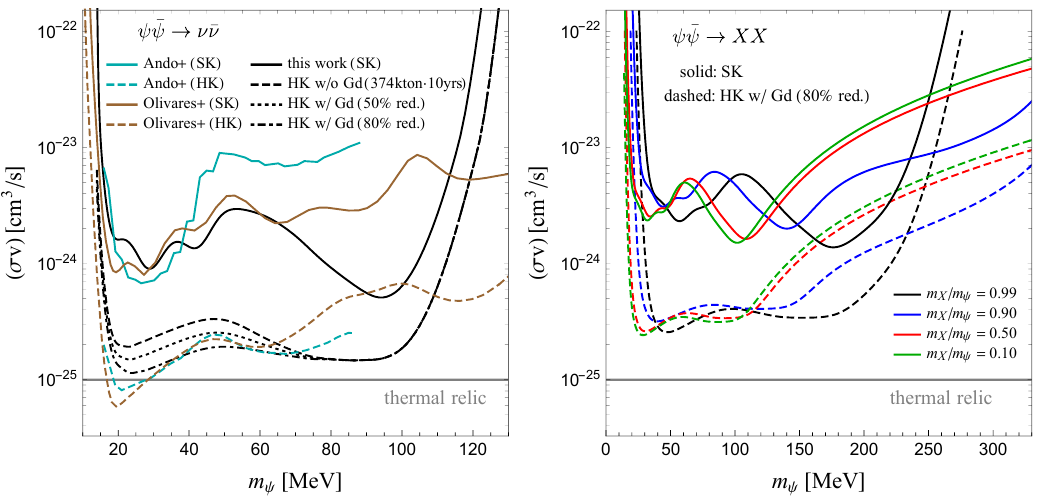
Figure 5 . The 90% C.L. upper limits on and the future HK sensitivity to the annihilation cross section for (cid:22) ! (cid:23) (cid:22) (cid:23) (left) and (cid:22) ! XX (right) cases. Black solid (dashed) line corresponds to the limit on the annihilation cross section from SK (HK). The results given in [40, 41] are shown for reference, and are shown in turquoise and brown